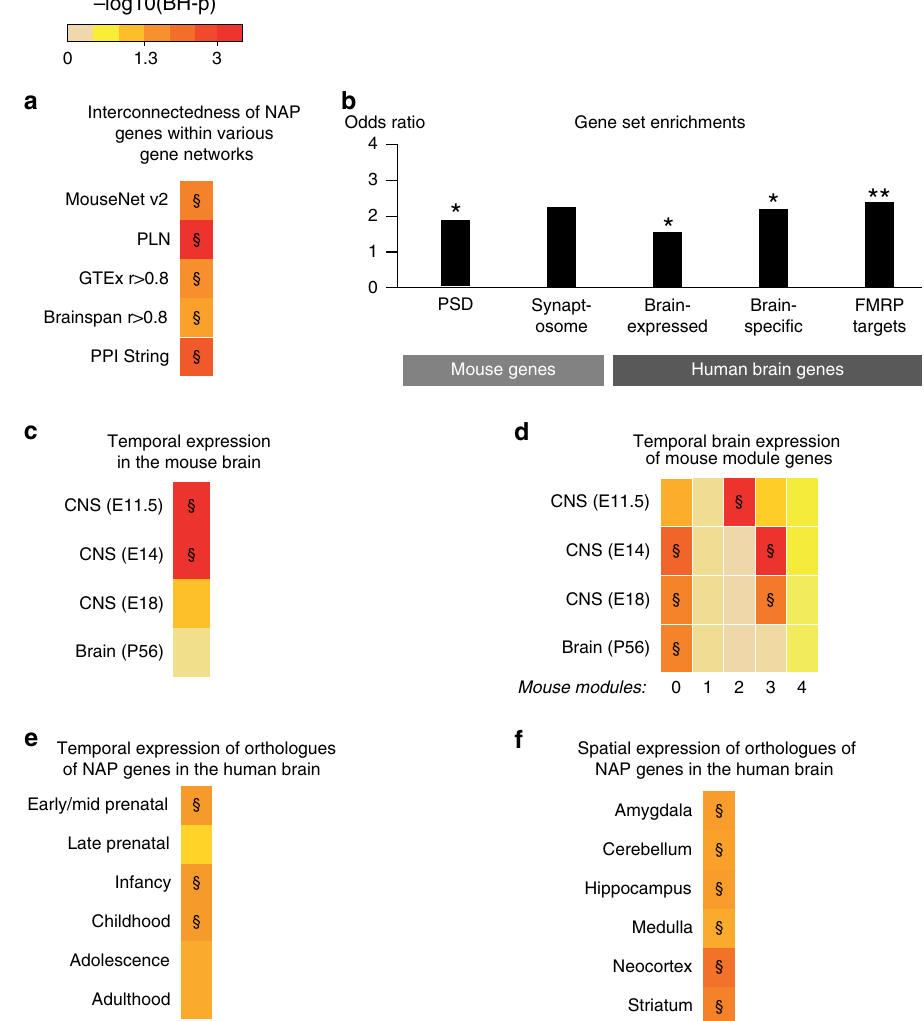
Fig. 4 Functional annotation of mouse NeuroAnatomical Phenotype (NAP) genes and their unique 1:1 human orthologs. All heat maps use the adjusted p value color key shown at the top of the fi gure with double S (§) referring to BH-p < 0.05 (permutation test). a Interconnectedness of mouse NAP genes and their human orthologs within various gene networks as compared to randomly sampled genes, matched for coding DNA sequence (CDS) and network connectivity. PLN Phenotypic Linkage Network, expression data GTEx, BrainSpan, PPI protein – protein interaction. MouseNet v2 uses mouse genes, while the remaining networks use unique human 1:1 orthologs. b Brain, synaptic, and Fragile X Mental Retardation Protein target gene enrichments observed among mouse NAP genes and their human orthologs compared to randomly sampled genes. Gene sets are described in Supplementary Notes. *0.05 < p